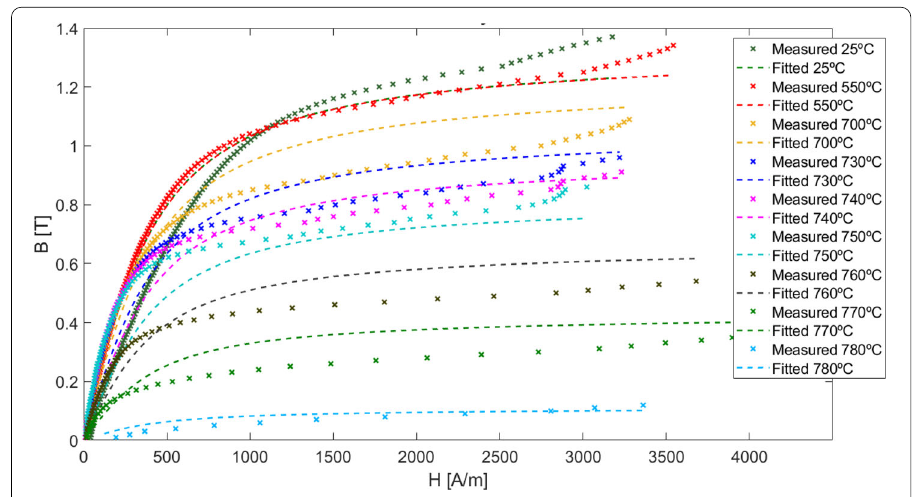
Fig. 2 Measured average magnetic hysteresis curves (symbols) at different temperatures and fitted values (hashed lines) for